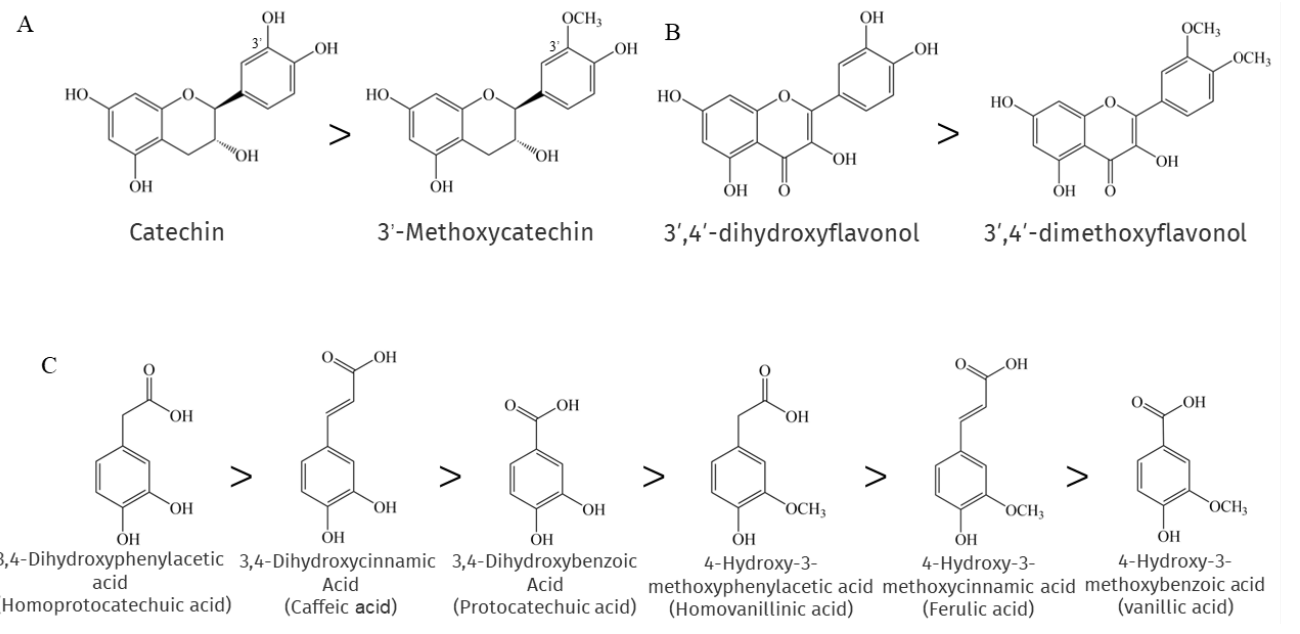
Figure 2. Comparison of the magnitude of the antioxidant capacity of some NEPs and their methylated compounds. Table 3. Structural formula of several common anthocyanins.